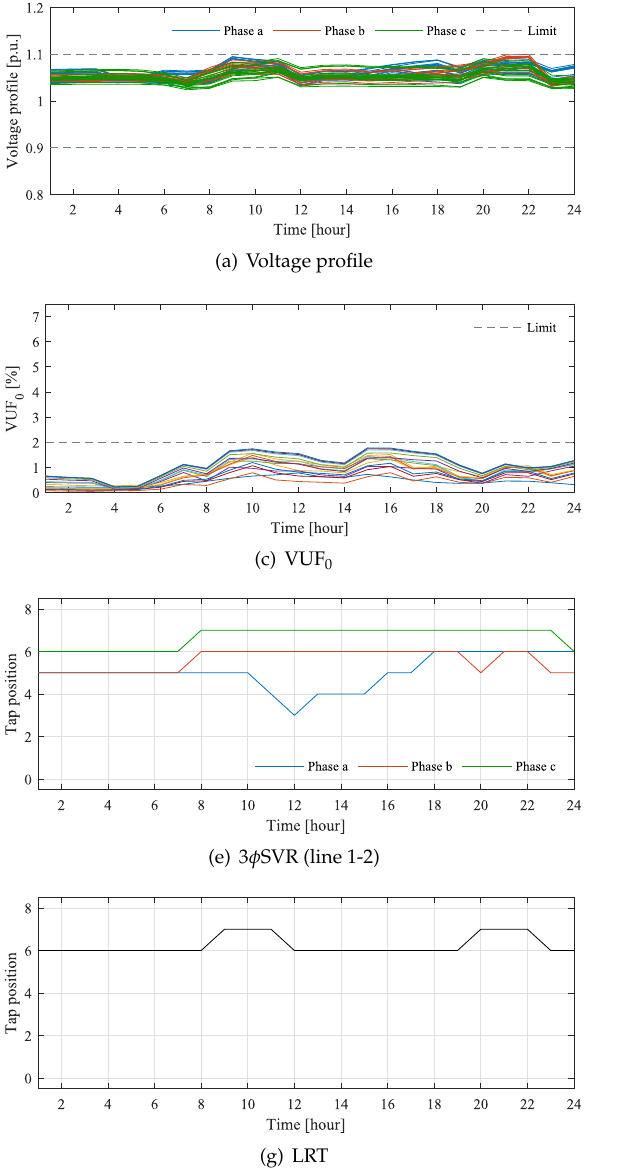
Figure 9. Simulation result of Case 5: minimize losses with voltage unbalance and tap operation penalty; the different colors in (b), (c), and (d) refer to different buses. All unbalance metrics are less than 2% for all-day while the taps of all devices are operated evenly.